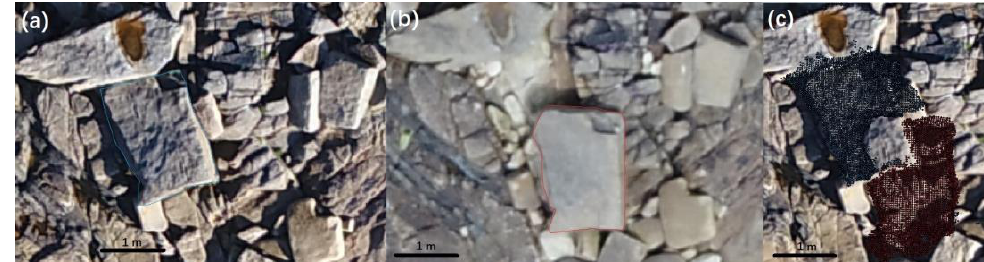
Figure 11. Example of a boulder moving less than the scale itself. ( a ) and ( b ) show the location of the boulder in 2017 and 2018, respectively; ( c ) shows the M3C2 result of this boulder.